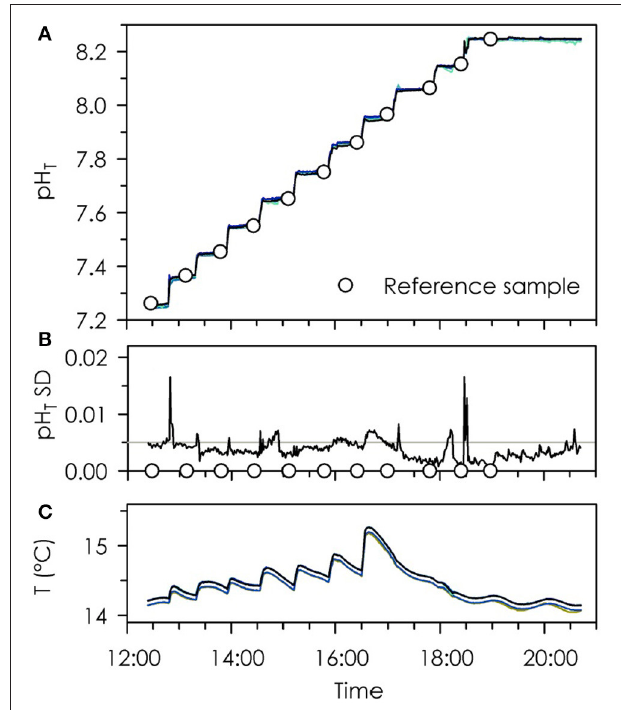
FIGURE 2 | Time-series of pH T (A) , pH T standard deviation (B) , and temperature (C) of eight Durafet pH electrodes during step-wise increases in seawater pH (lines in A,C are superimposed). Circles represent reference pH samples using the spectrophotometric method with m -cresol purple (A) and sample time points (B) . Reference line in (B) indicates a standard deviation of